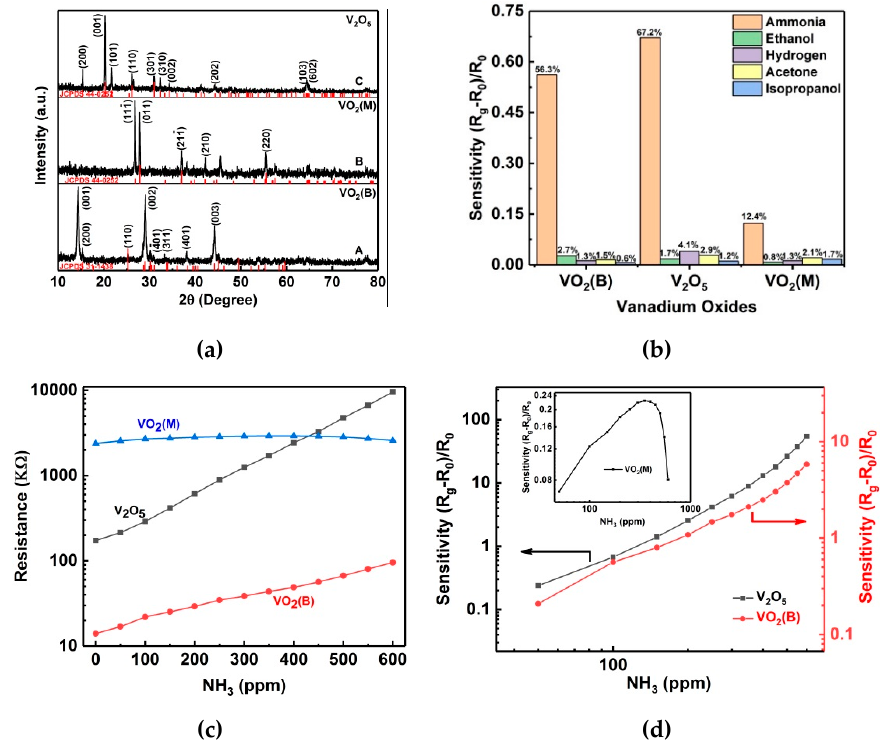
Figure 4. ( a ) XRD patterns of self-assembled VO 2 (B), VO 2 (M) and V 2 O 5 specimens. ( b ) Selectivity